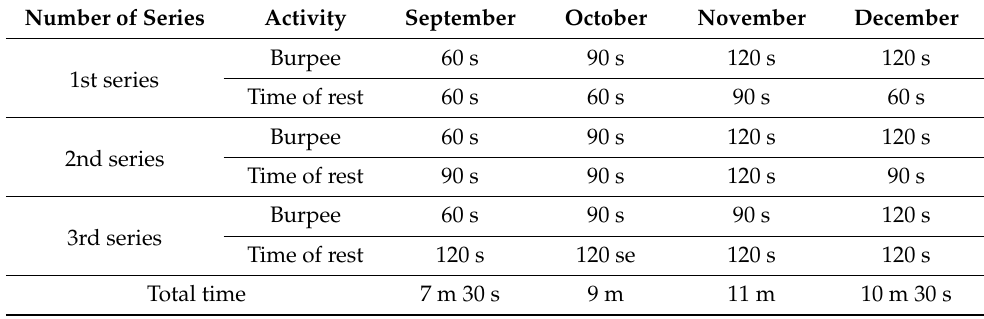
Table 1. Over-time Burpee exercise administration features for adolescents aged 15–16 years. Number of Series